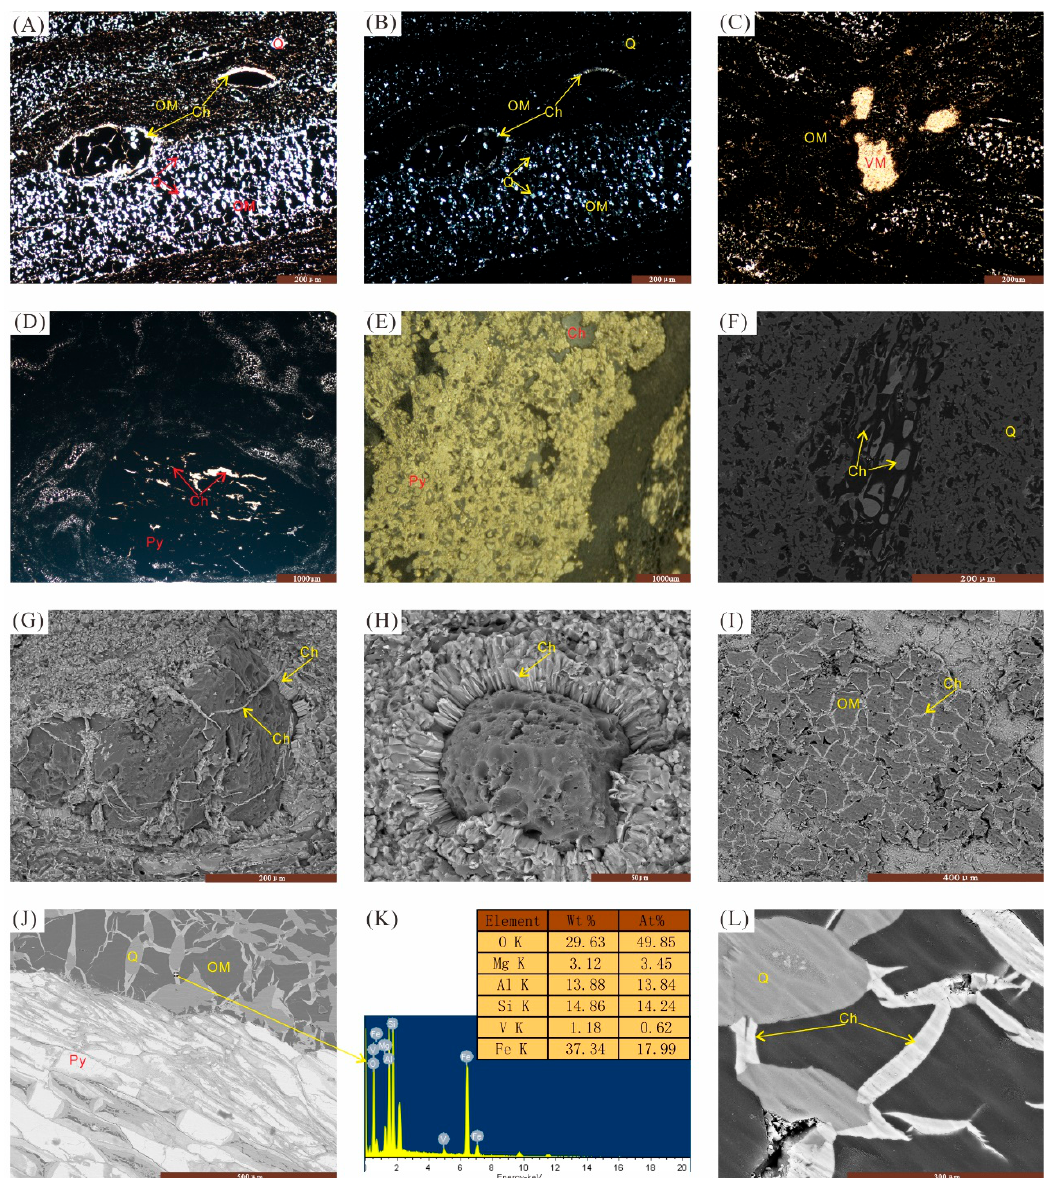
Figure 5. Chamosite occurrence modes in coal. ( A ) Fibrous aggregate that envelops organic matter and occurs as cleat/fracture infillings in PPL; ( B ) Photomicrographs of ( A ) under XPL; ( C ) Chloritic matrix associated with volcanic matter in PPL; ( D ) Chamosite as cleat/fracture infillings within pyritic coal balls in PPL; ( E ) Photomicrographs of ( D ), reflected light in air; ( F ) Chamosite as cell infillings SEM BSED; ( G ) Fibrous aggregate that envelops organic matter and occurs as cleat/fracture infillings SEM BSED; ( H ) Fibrous aggregate that envelops carbon microparticle SEM BSED; ( I ) Chamosite as cleat/fracture infillings closely associated with quartz component SEM BSED; ( J ) Chamosite as cleat/fracture infillings closely associated with quartz component SEM BSED; ( K ) EDS data for chamosite; ( L ) Chamosite as cleat/fracture infillings closely associated with quartz component SEM BSED. Py, pyrite; Q, quartz; Ch, chamosite; OM, organic matter; VM, volcanic matters. ( G – I ) the naturally exposed surface; ( F , J , L ) ion-polished surface.